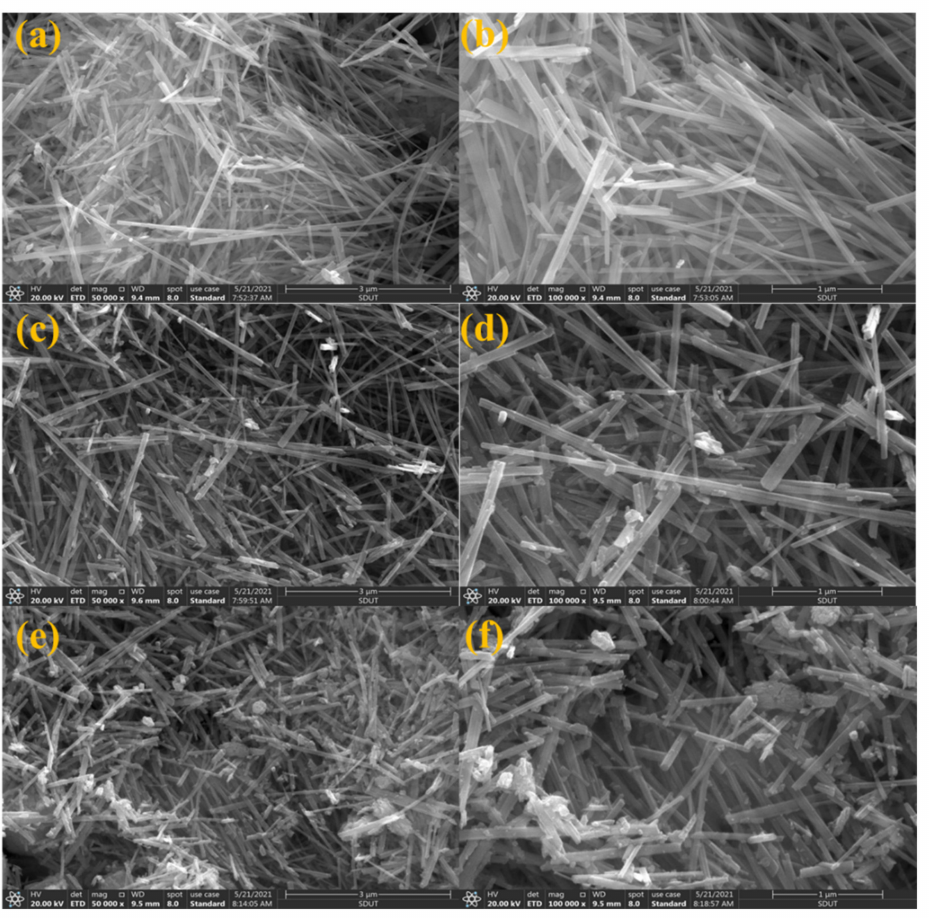
Figure 2. SEM images of α -MnO 2 nanowire support ( a , b ), 5CuO/ α -MnO 2 -200-DP ( c , d ) and 30CuO/ α -MnO 2 -200-DP ( e , f ) catalysts.